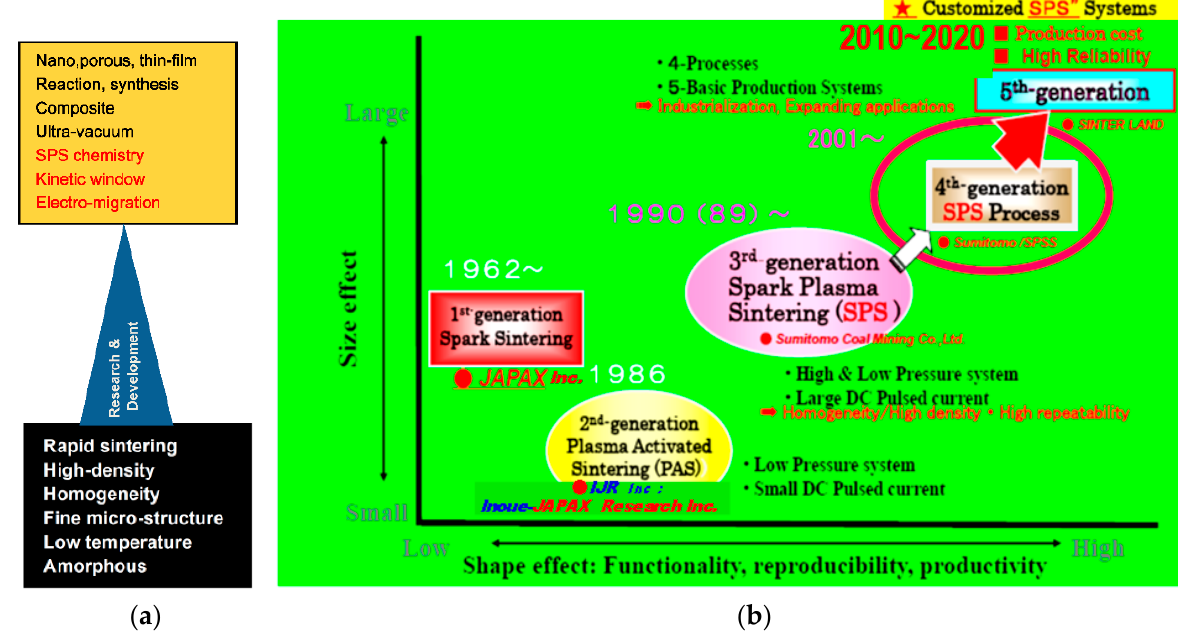
Figure 2. Historical progress on Spark Plasma Sintering (SPS) method and technology; ( a ) Materials based technological Keywords-beginning to today; ( b ) Industrialization, SPS apparatus manufacturers and hardware/applications/objectives features.